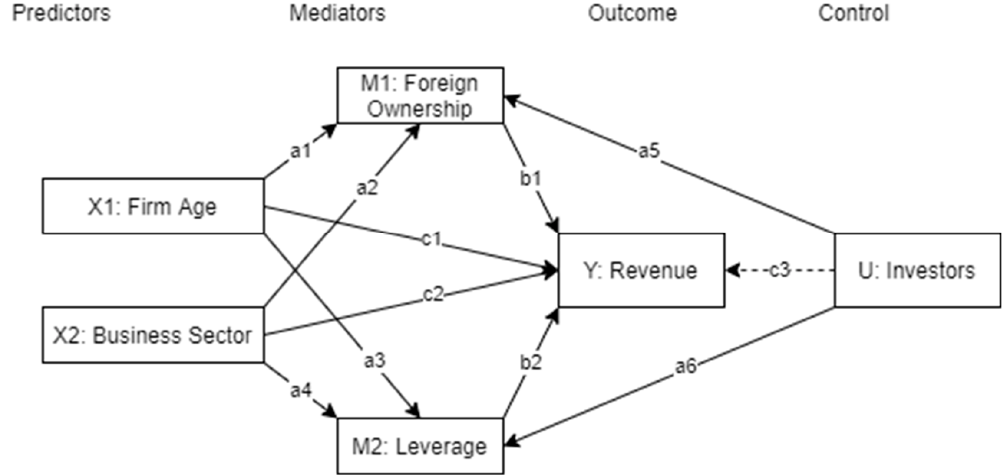
Figure 1. Direct and Indirect Effects Statistical Framework . Source: Authors conceptualization.